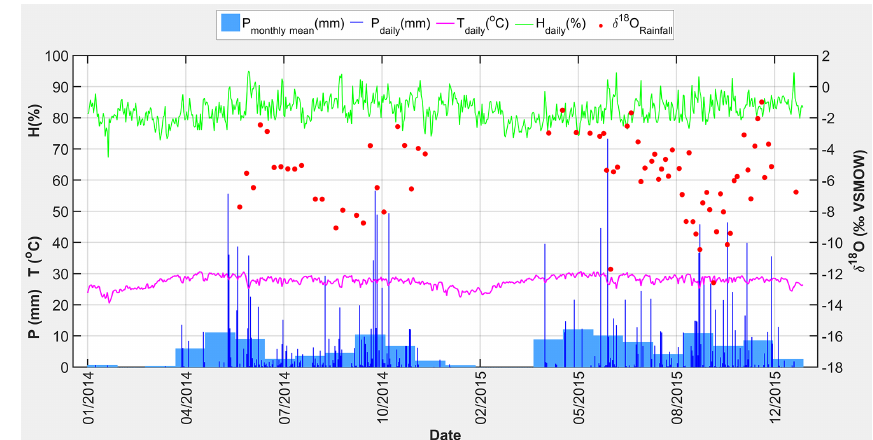
Figure 3. Climate data from the Cao Lanh meteorological station for the study period. Daily temperature ( T ) is given together with monthly and daily precipitation ( P ) and daily relative humidity ( H ). Weekly and bi-weekly δ 18 O (‰ VSMOW) values of rainwater are presented as red circles.